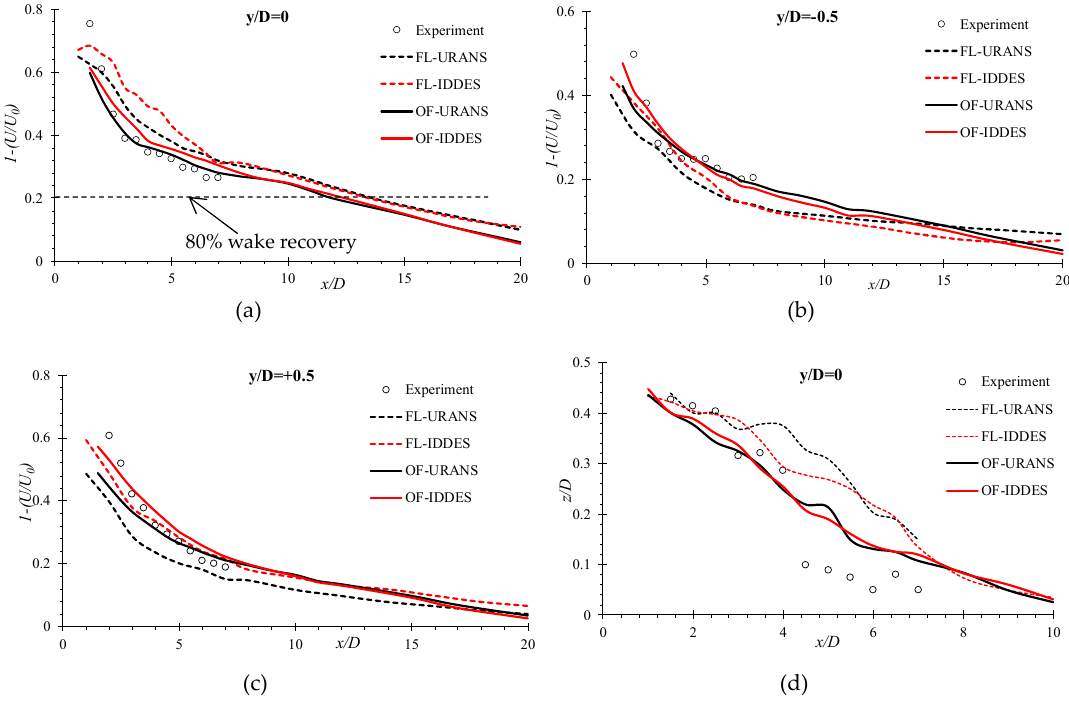
Figure 10. Validation URANS and IDDES wake deficit predictions from Ansys/Fluent and OpenFOAM using experimental data [2]. Variation of peak wake deficit downstream of turbine at: ( a ) y/D = 0, ( b ) y/D = -0.5 and ( c ) y/D = 0.5 planes. ( d ) Spanwise location of peak deficit at y/D = 0.